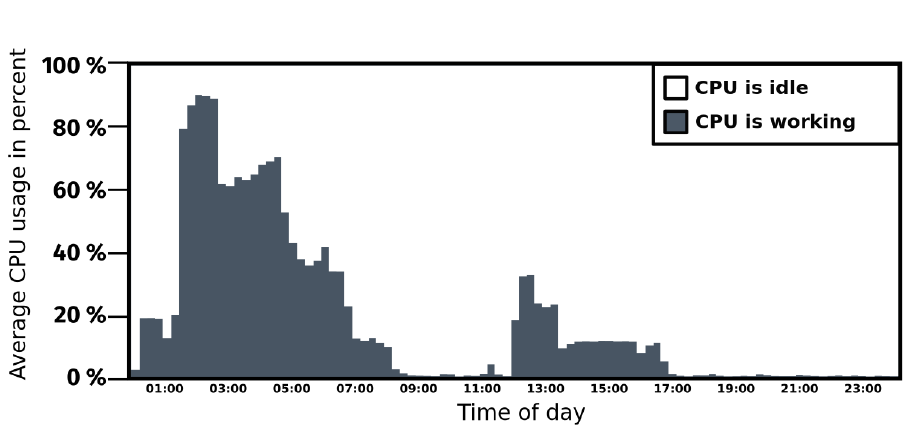
Figure 1. The average CPU utilization of build nodes active during the nightly build process. After the initial peak most of the compute resources go unused, and could be made available to other processes or user